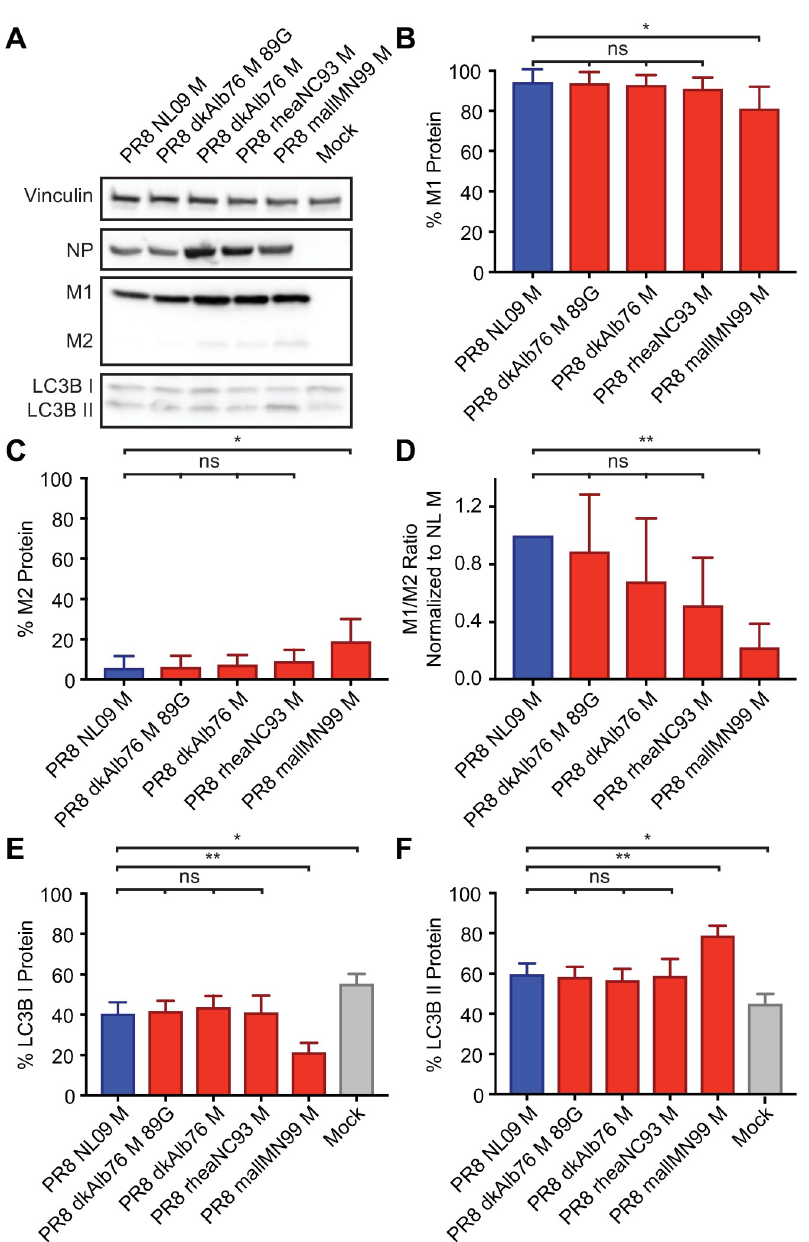
Fig 4. Ratio of M1 to M2 protein expression is high in DF-1 Cells irrespective of viral M segment host origin. DF-1 cells were inoculated at a MOI of 5 PFU/cell, with PR8 viruses encoding avian or human-derived M segments, and incubated at 37˚C for 8 h, then lysed. Western immunoblot analysis of virus-infected DF-1 cells: (A) Vinculin expression was measured to allow normalization of viral protein levels. NP expression was measured to assess viral replication. Levels of M1 and M2 protein expression were assessed using an antibody (Mab E10) to a common epitope at the amino terminus of M1 and M2 proteins, allowing relative expression to be assessed. Levels of LC3B I and II were assessed using an antibody that detects both the precursor and activated forms of LC3B protein. (B) M1 protein and (C) M2 protein were normalized to vinculin, quantitated and displayed as a percentage of total protein expressed from the M gene. (D) The ratio of M1:M2 protein expression. (E) LC3B I protein and (F) LC3B II protein were normalized, quantitated and displayed as a percentage of total LC3B protein. Graphs in B-F show the means with SD from three independent experiments. For each experiment, two replicate Western immunoblots were performed and quantitated. Statistical significance was assessed using ordinary one-way ANOVA.